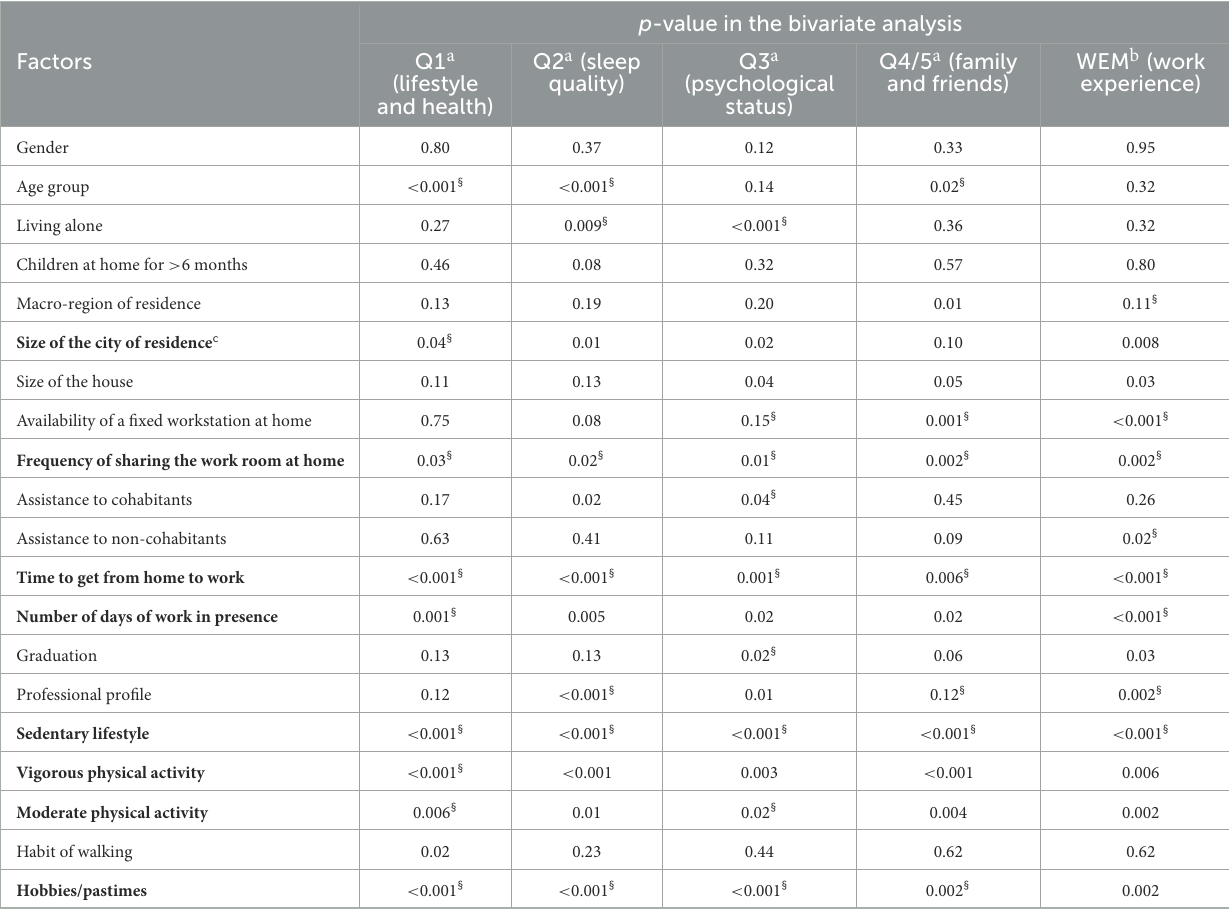
TABLE 2 Bivariate association of socio-demographic, individual, familiar and individual organizational factors with life dimension and work dimension.